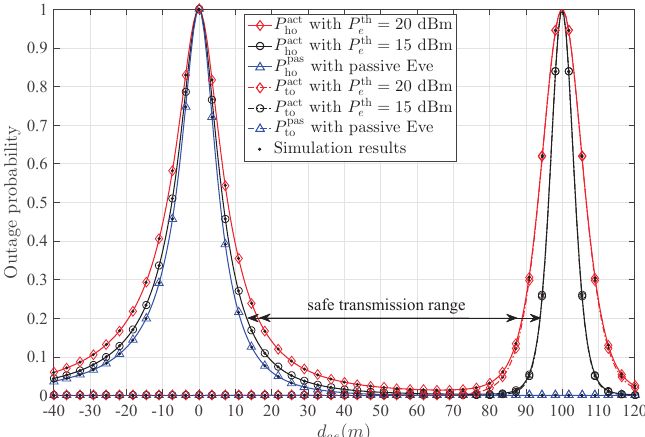
Figure 8. The influence of P th e on the outage probability.